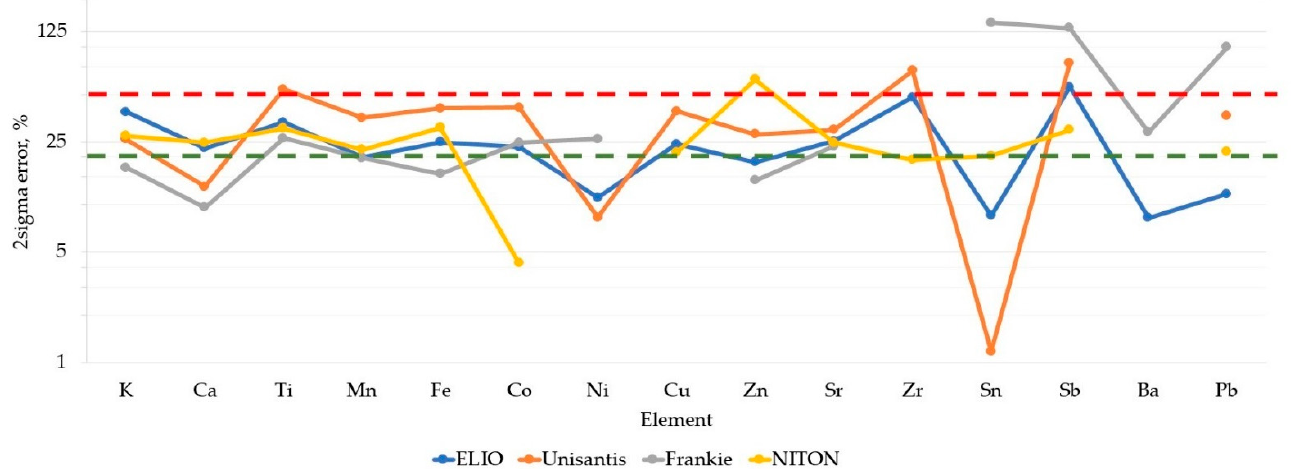
Figure 3. Estimation of the analytical precision for each XRF unit as the percentage difference from the mean value of repeated measurements. ELIO and NITON: ten replicates of CMOG reference glasses. The remaining data are calculated from the triplicate acquisitions. Frankie data only features CMOG values. The green dotted line is a 20% level of dispersion. The red dotted line is a 50% level of dispersion. Logarithmic scale.